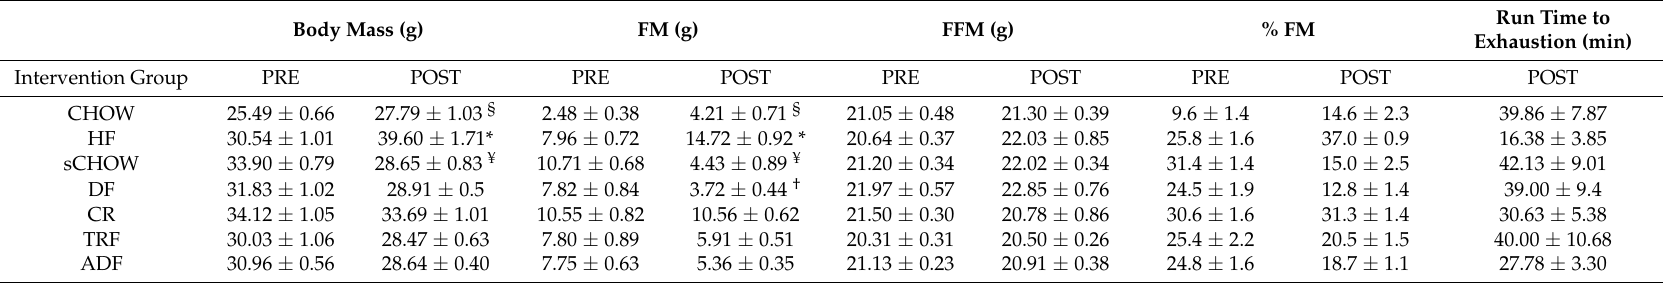
Table 4. Anthropometric and run-time-to-exhaustion data for male mice assigned to seven different dietary protocols for eight weeks. Body Mass (g)